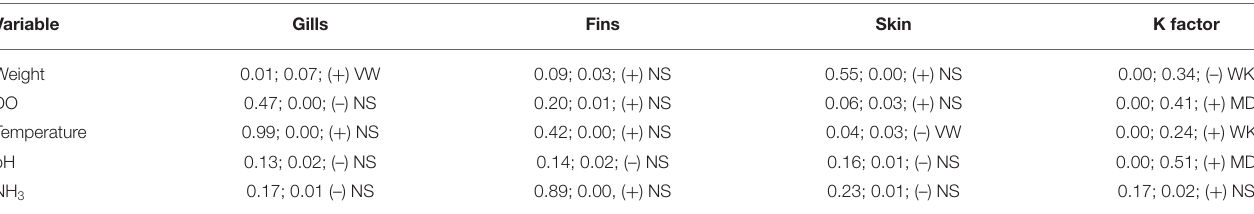
Correlation strenght based on r 2 range: (VW) Very Weak: 0.00–0.19; (WK) Weak: 0.20–0.39; (MD) Moderate: 0.40–0.69; (ST) Strong: 0.70–0.89; Very Strong (VS): 0.89–100; (NS); Not significant (p >